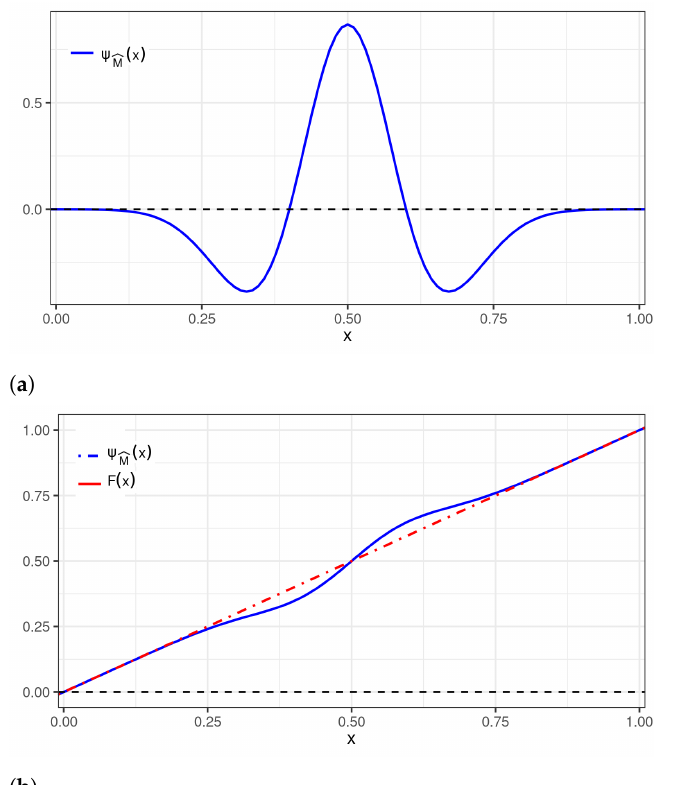
Figure 5. Plots of: ( a ) a Mexican-hat wavelet perturbation to be applied to the U [ 0,1 ] distribution; and ( b ) Mexican-hat wavelet perturbation (— blue) and uniform (- · - red) CDFs.